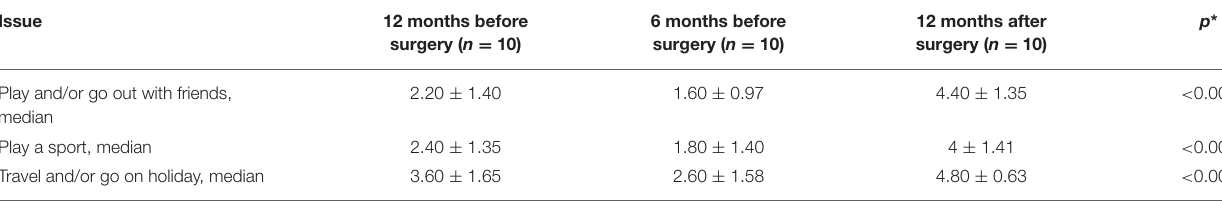
TABLE 3 | Social activities score preoperatively and 6 and 12 months after surgery.